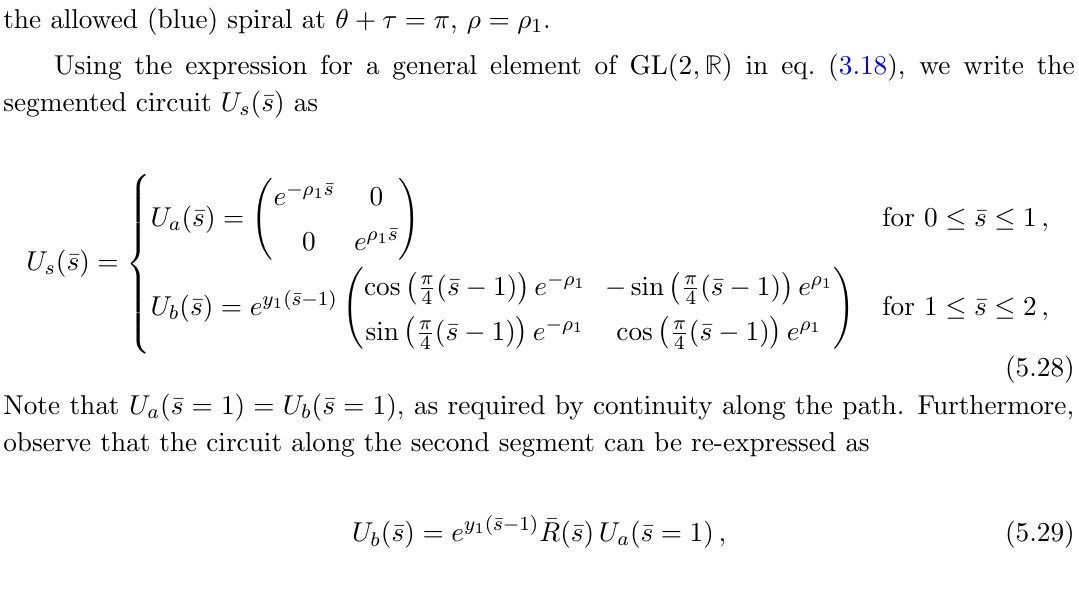
geodesic in the original geometry (3.19) to that in the new penalized geometry (5.2). One feature that the (cid:12)gure emphasizes is that these two geodesics end at di(cid:11)erent points along the allowed (blue) spiral at (cid:18) + (cid:28) = (cid:25) , (cid:26) = (cid:26) . 1 Using the expression for a general element of GL(2 ; R ) in eq. (3.18), we write